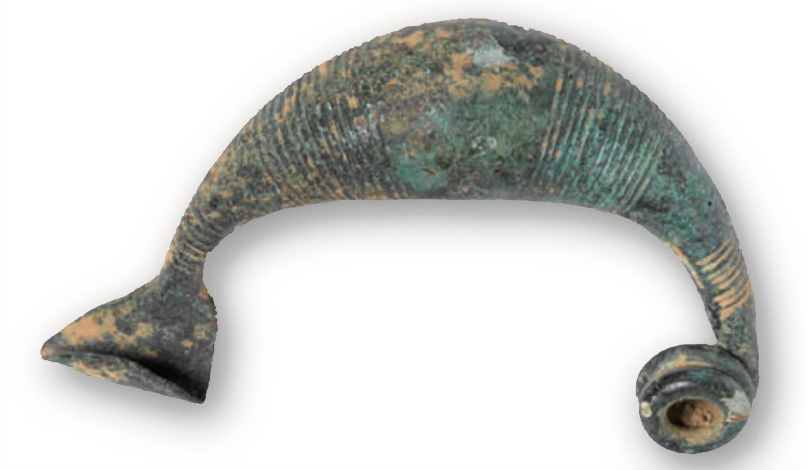
Figure 6. Fibula from cult complex of Sa Sedda ‘ Sos Carros in Oliena (from Gianfranca Salis 2014, p. 285, n.